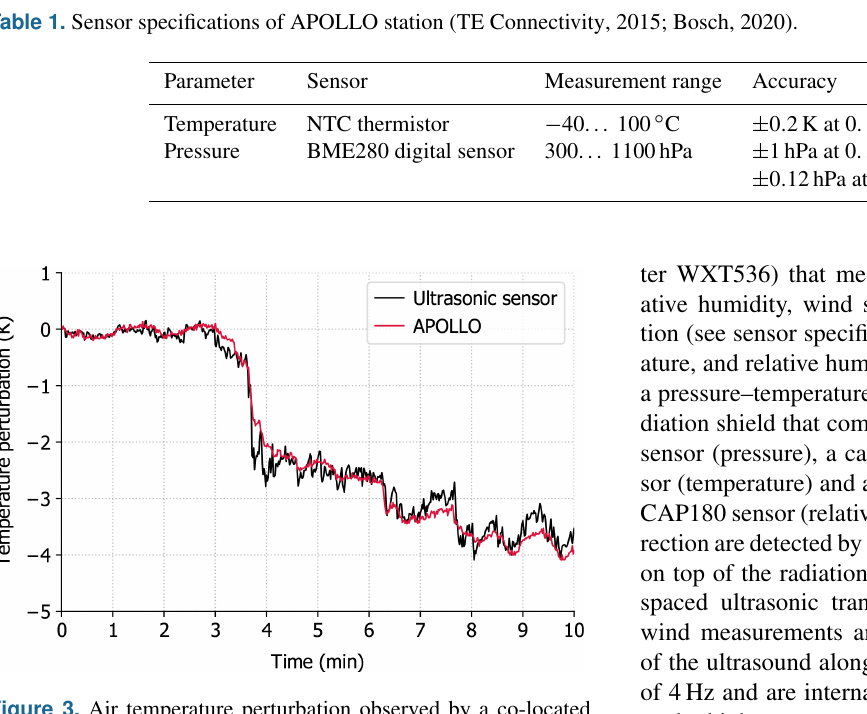
Figure 3. Air temperature perturbation observed by a co-located ultrasonic sensor and APOLLO station during a cold pool event at the Meteorological Observatory Lindenberg – Richard Aßmann Observatory (eastern Germany) on 26 August 2019. The readings of the ultrasonic sensor are 1s averages of 20Hz acoustic temper- ature measurements by an ultrasonic anemometer (type: METEK uSonic-3